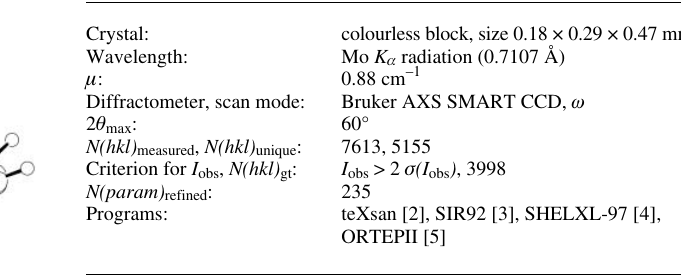
Table 1. Data collection and handling.